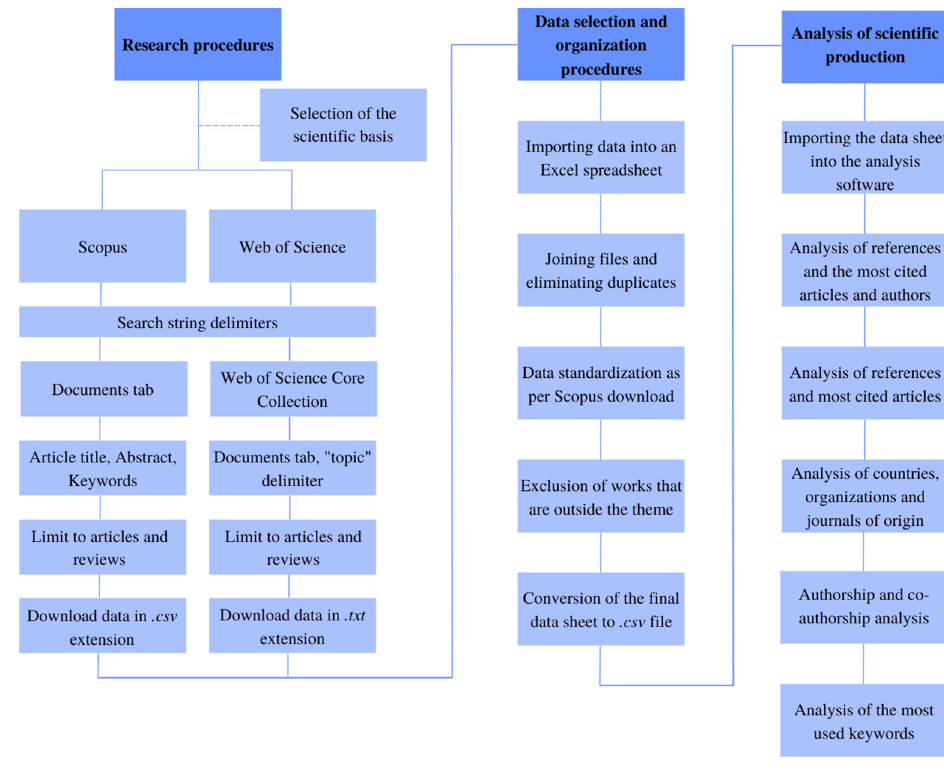
Figure 1. Systematization of the process for carrying out the bibliometric analysis.